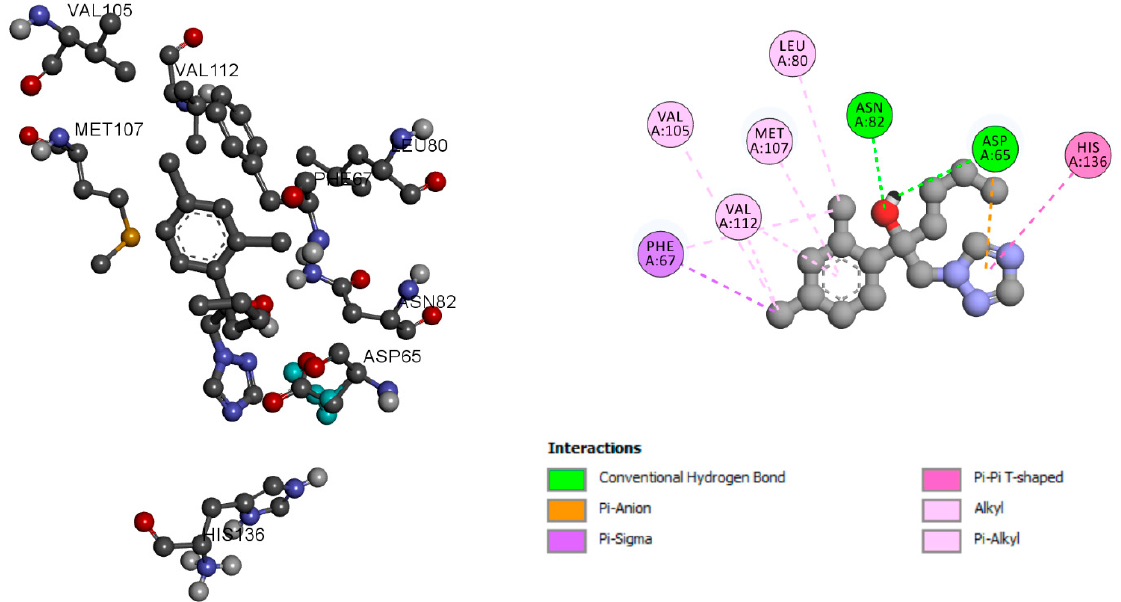
Figure 1. SHBG molecular interaction pattern with hexaconazole.